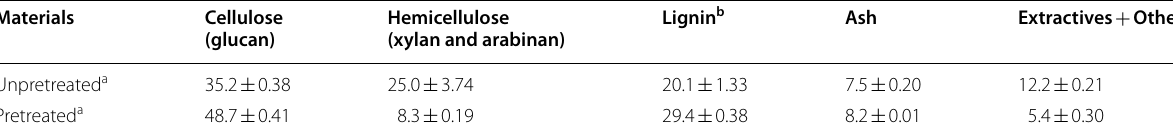
Table 1 Main chemical compositions of untreated and treated Pennisetum purpureum (% of DM)